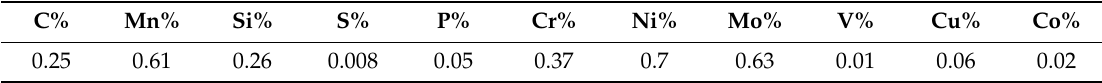
Table 2. Chemical composition of A508 Cl2